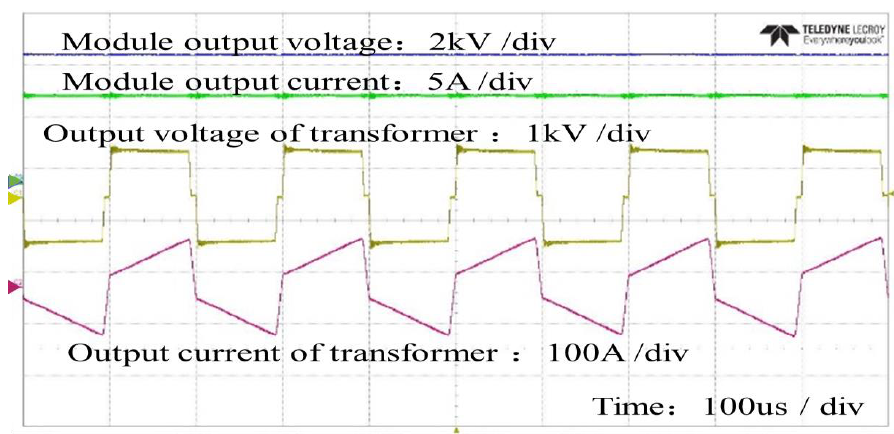
Figure 17. Stable operation voltage and current of DC/DC module.